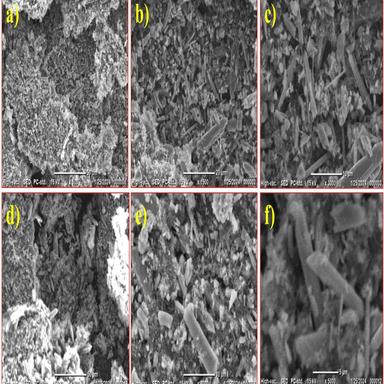
Ex situ SEM images of IL-β-MNV after the 100 cycles of charging and discharging at 1C rate.